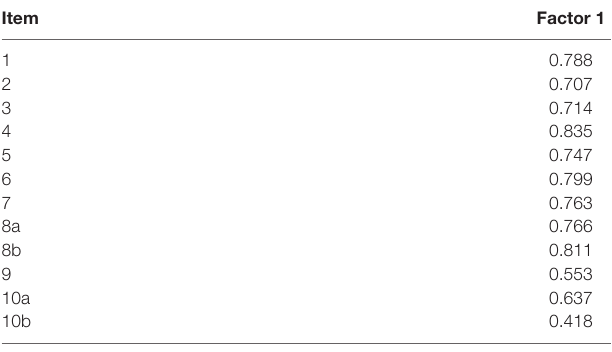
TABLE 2 | Component matrix a of the MDI.